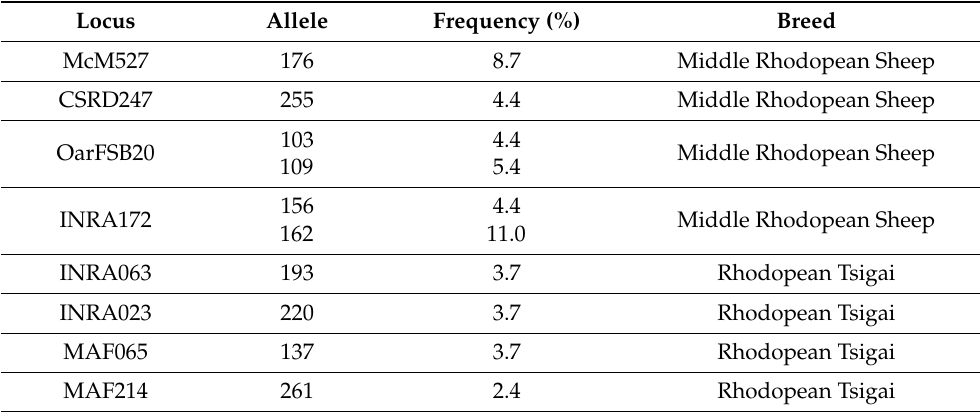
Table 4. Identified population-specific alleles. Locus